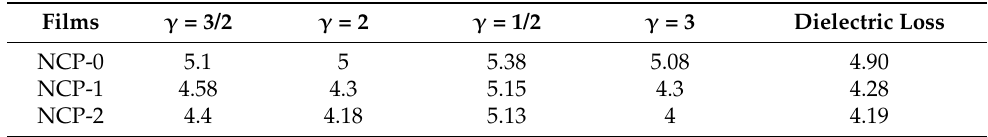
Table 2. The E g values from Tauc’s method and ε i